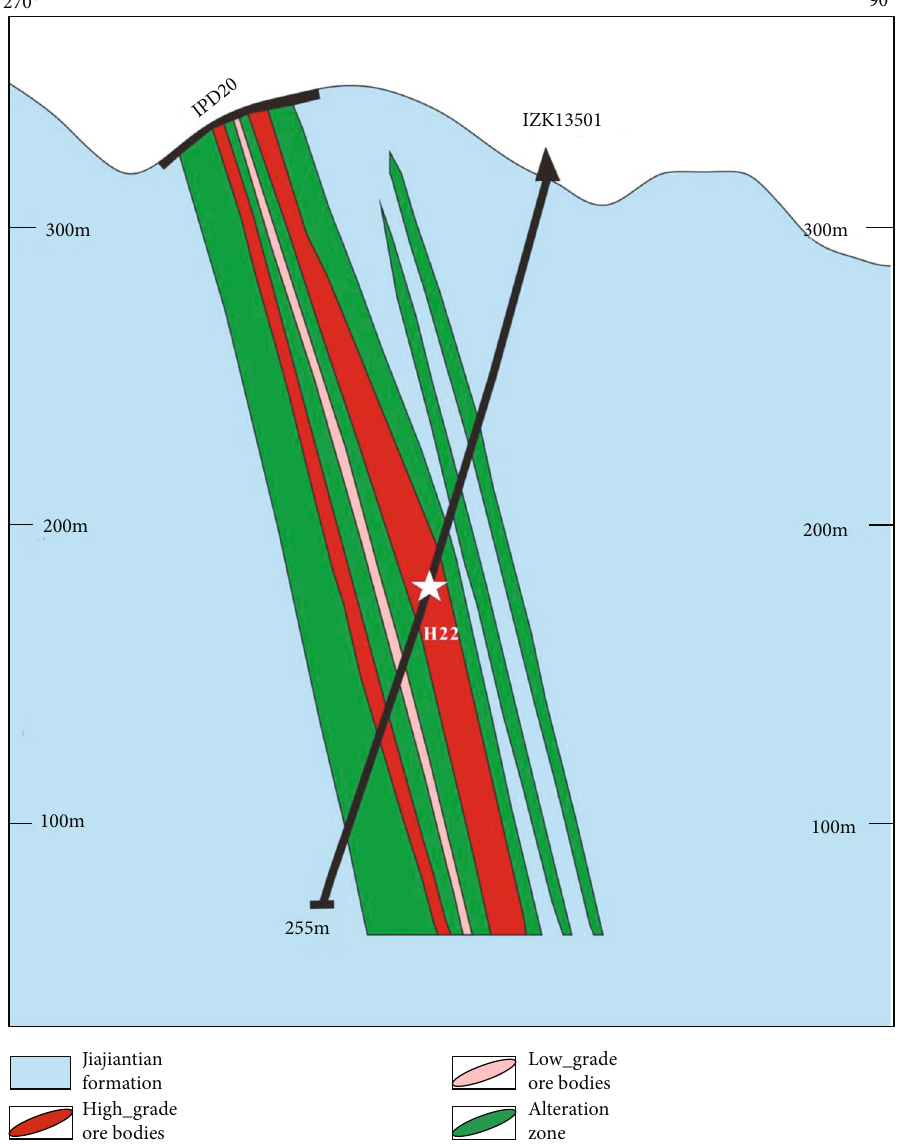
Figure 3: Geologic cross-section (prospecting line 135) of the Daping gold deposit (modi fi ed after